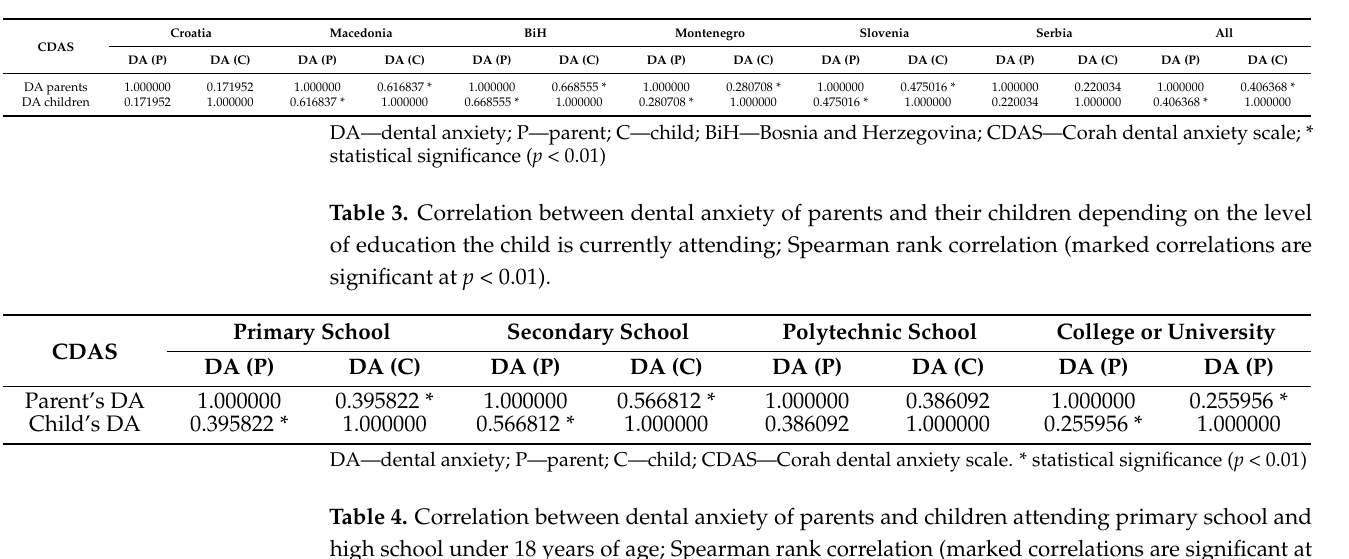
Table 2. Correlation between dental anxiety of children and parents by individual countries; Spear- man rank correlation (marked correlations are significant at p < 0.01).